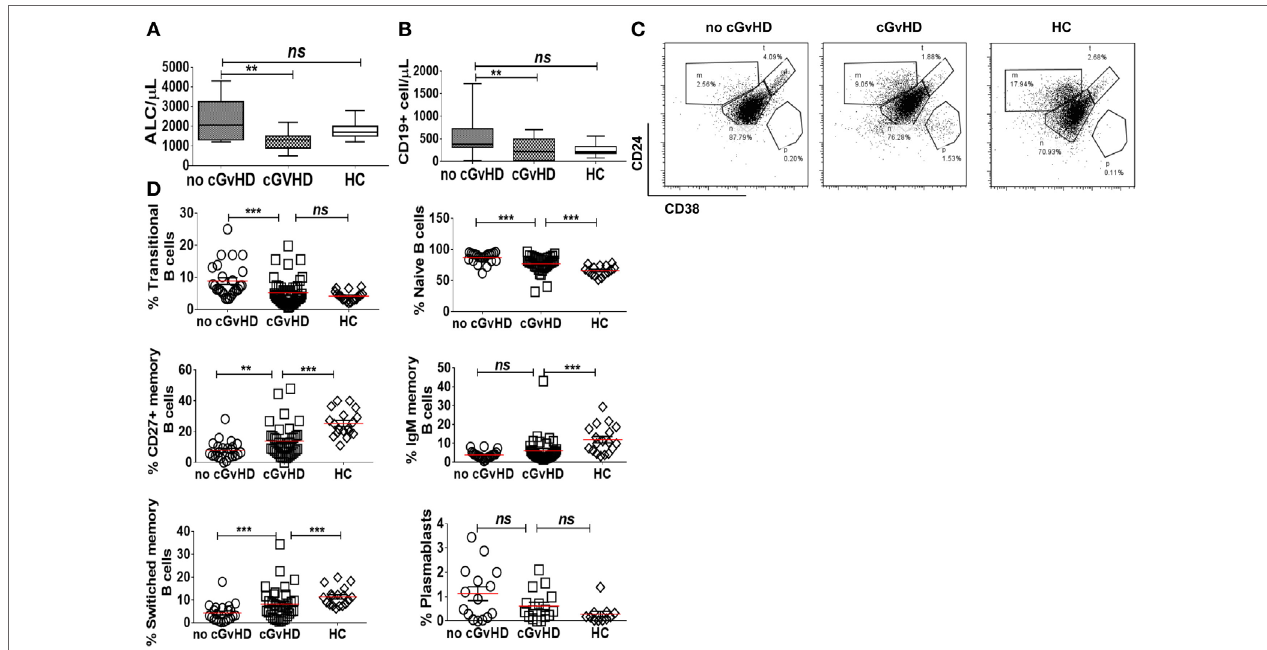
FigUre 1 | B cell subsets in patients with or without chronic graft-versus-host disease (cGvHD) and healthy controls (HC). Box plots, showing medians, 25th and 75th percentiles and ranges, compare total lymphocyte count (a) and total CD19 + B cell count (B) in cGvHD patients compared to “no cGvHD” patients and HC. (c) Representative FACS plots demonstrating CD19 + B cell phenotype in a “no GvHD,” a cGvHD patient and a healthy control. Gated CD19 + B cells were examined for CD24 and CD38 expression; transitional (CD19 + CD24hiCD38hi), naïve (CD19 + CD24 + CD38 + ) and memory (CD19 + CD24hiCD38 − ) B cell subsets are presented. (D) Scatter plots compare the percentage of individual B cell subsets in patients with “no GvHD” ( n = 23), with cGvHD ( n = 32) and HC ( n =